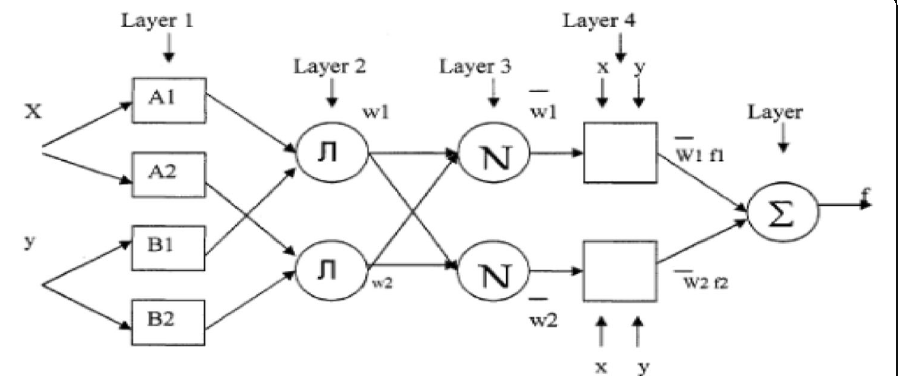
Fig. 12 The structure of the ANFIS. An adaptive network is a network structure that contains five layers and links a number of nodes to a number of links. The nodes represent processing units and the links show the connection between those processing units. The rules of learning are made in a way to reduce the system error and correct the node parameters as they should. To determine the parameters, the ANFIS uses